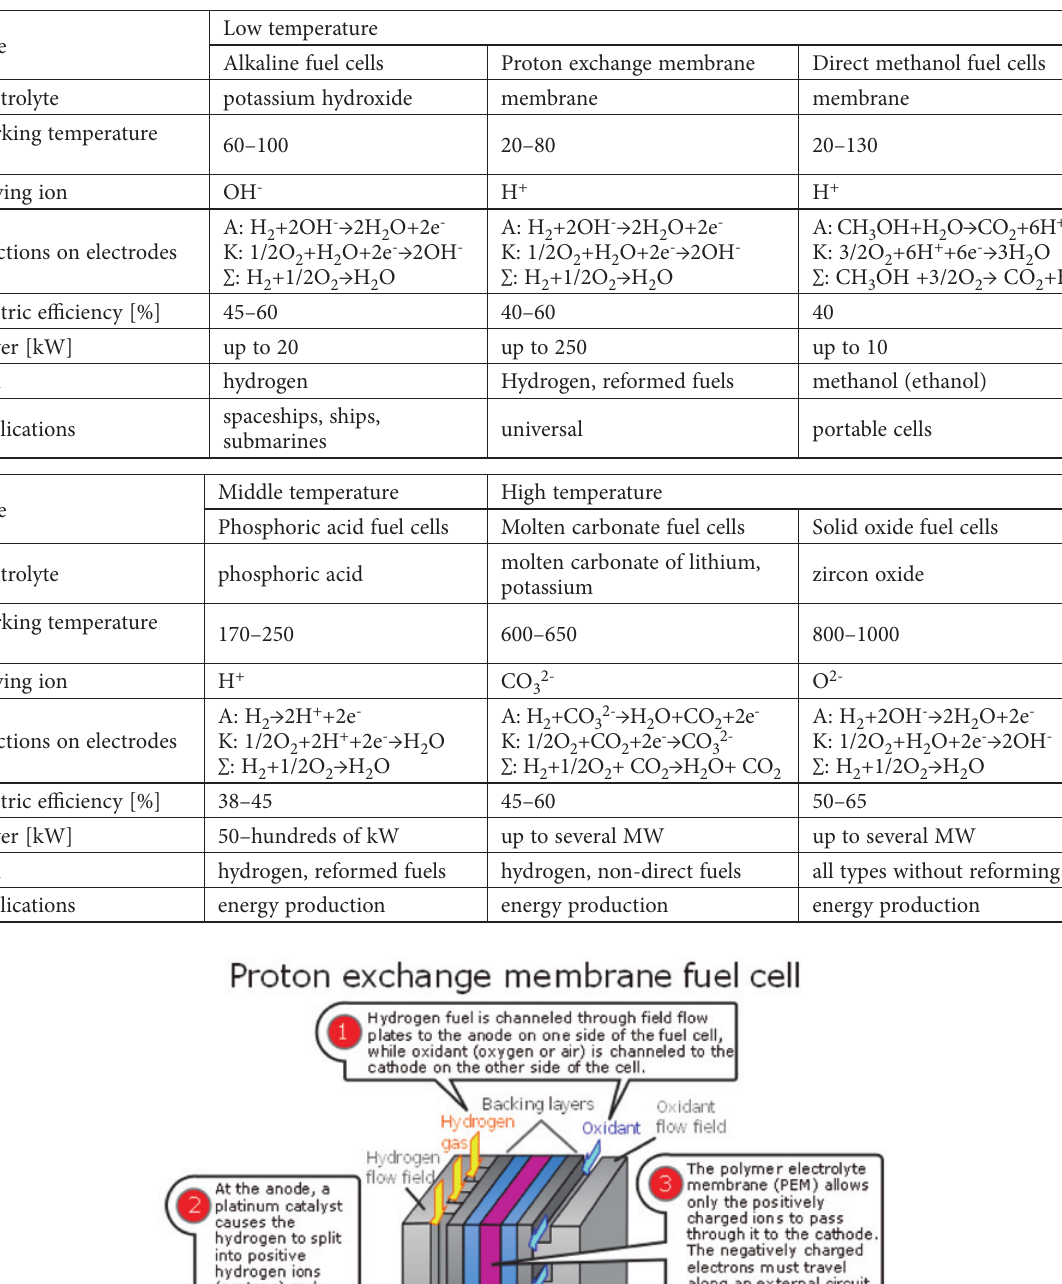
Table 1. Types of fuel cells